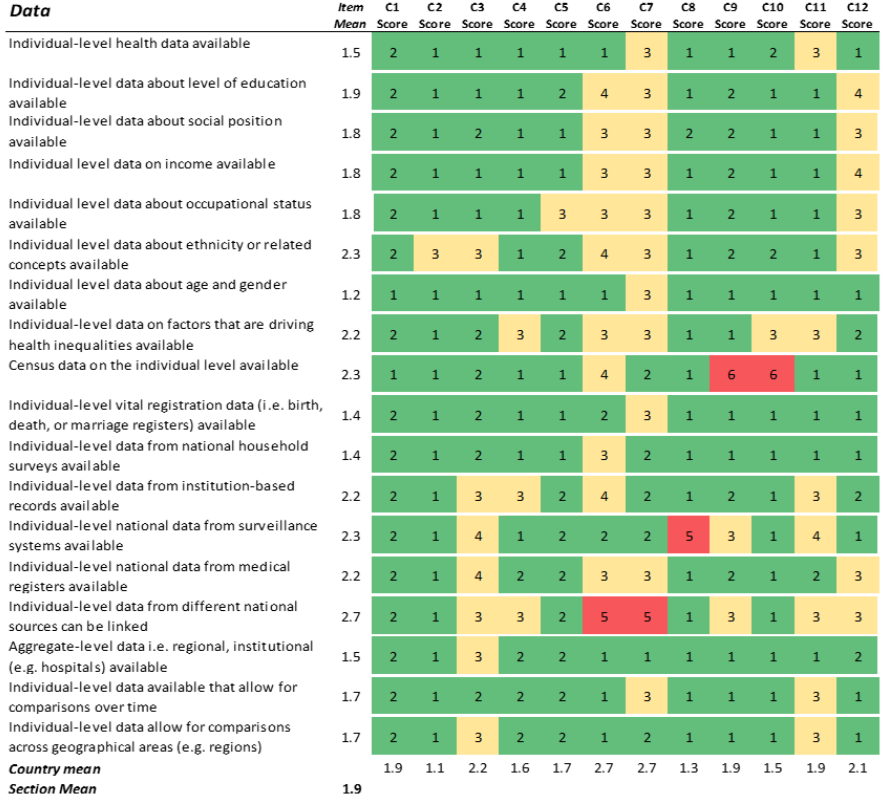
Figure 2. Results for the section ‘Data’. Green cells (scores 1–2) indicate agreement with the statement. Yellow cells (scores 3–4) indicate partial agreement/disagreement, and red cells (scores 5–6) indicate the most challenging preconditions for an ideal HIMS.